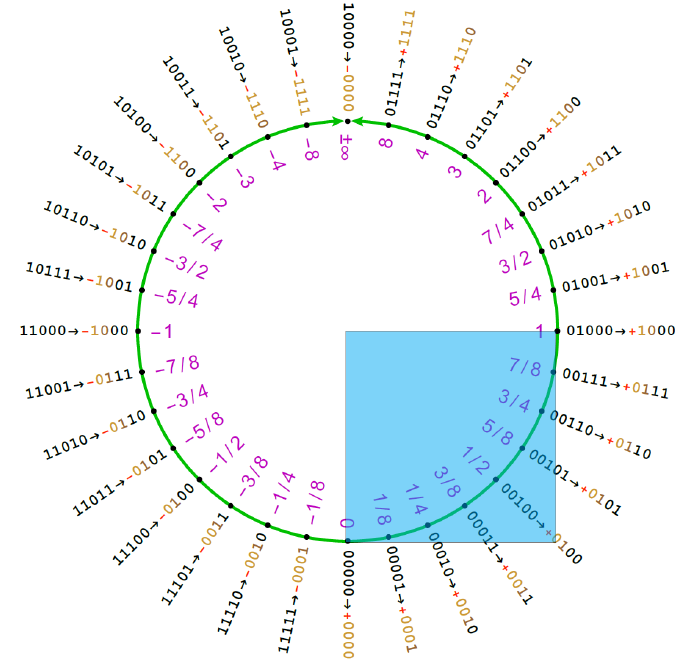
Figure 4. The [ 0,1 ] quadrant in the Posit ring.